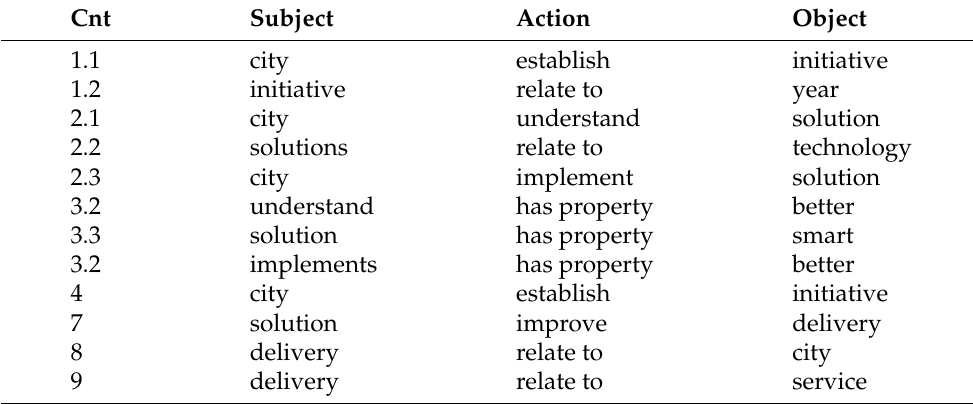
Figure 2. Dependency tree for terms in the triplet “ City better understand smart technology solutions ”. Table 2. Example triplets generated after processing the dependency tree using the Stanford CoreNLP package. Duplicates were